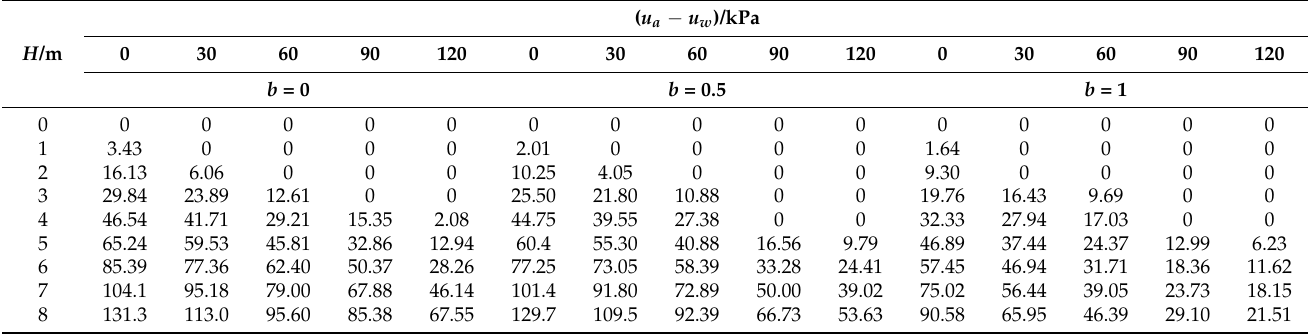
Table 1. Intensity values of Rankine active earth pressure and matric suctions. Table 2. Intensity values of Rankine active earth pressure and matric suction related friction